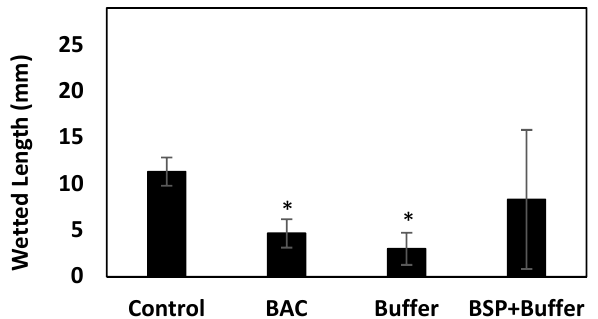
Figure 9. Tear secretion acquired by Schirmer’s test (n = 3), *p < 0.05 compared to control group by one-way ANOVA.